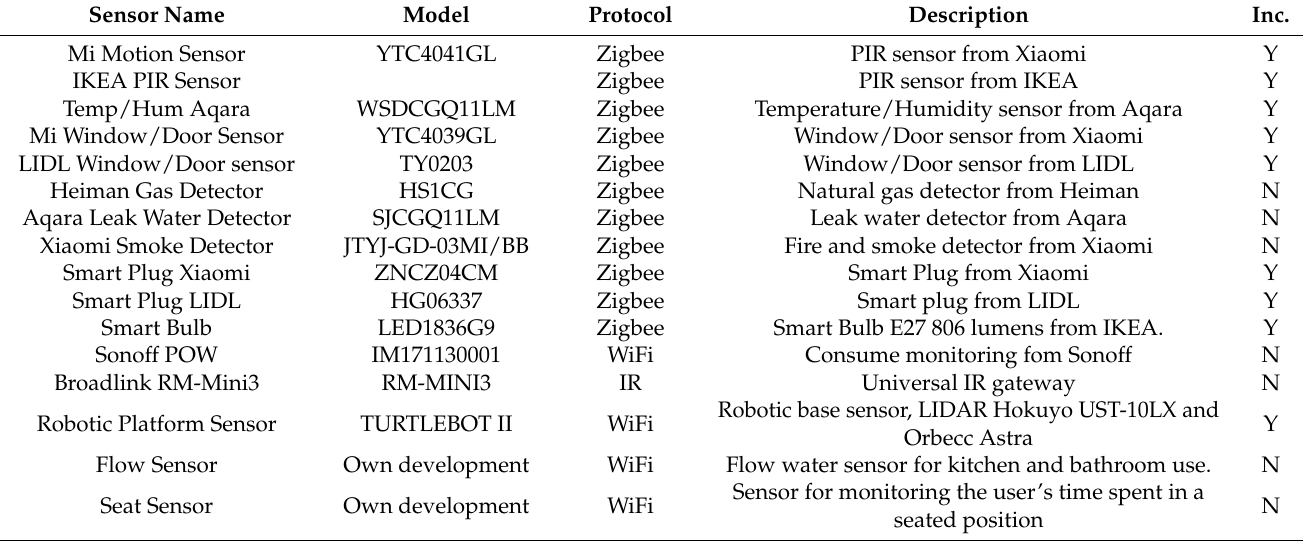
Table 3. Home automation system